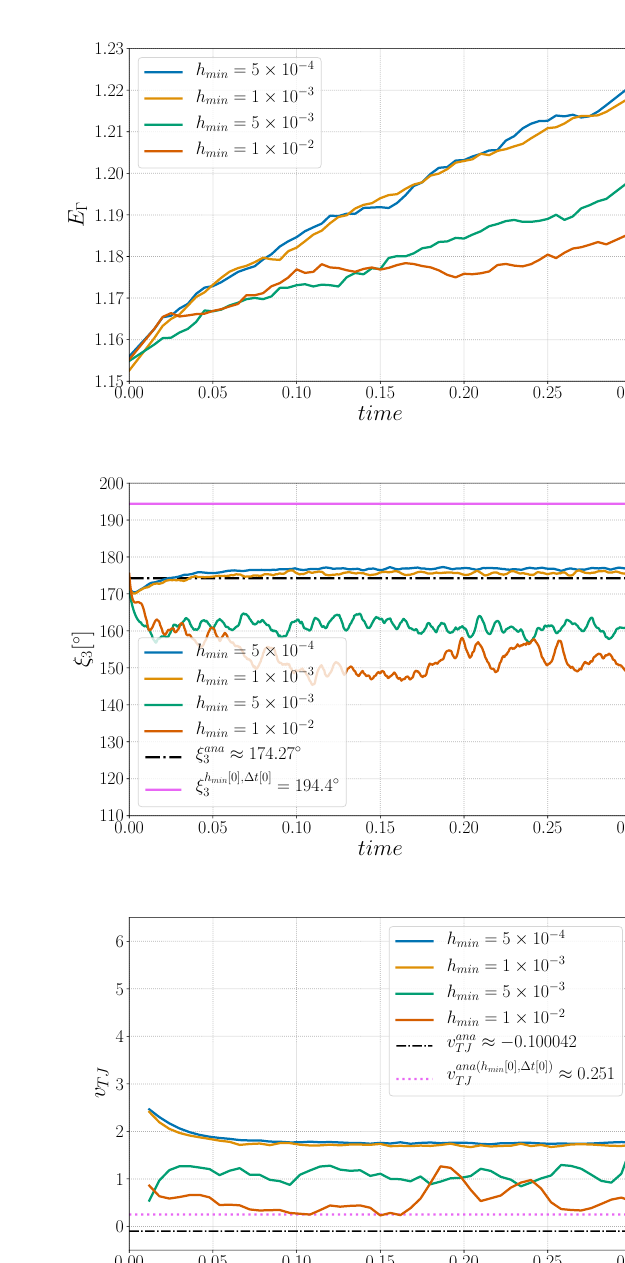
Figure 6. Sensibility analysis for the HetGrad formulation in ( left ) time for h min = 1 ∆ t = 1 10 − 4 : ( Top ) interfacial energy sensibility, ( middle ) triple junction angle, ξ 3 , sensibility analysis, and ( bottom ) × triple junction velocity, v TJ , sensibility